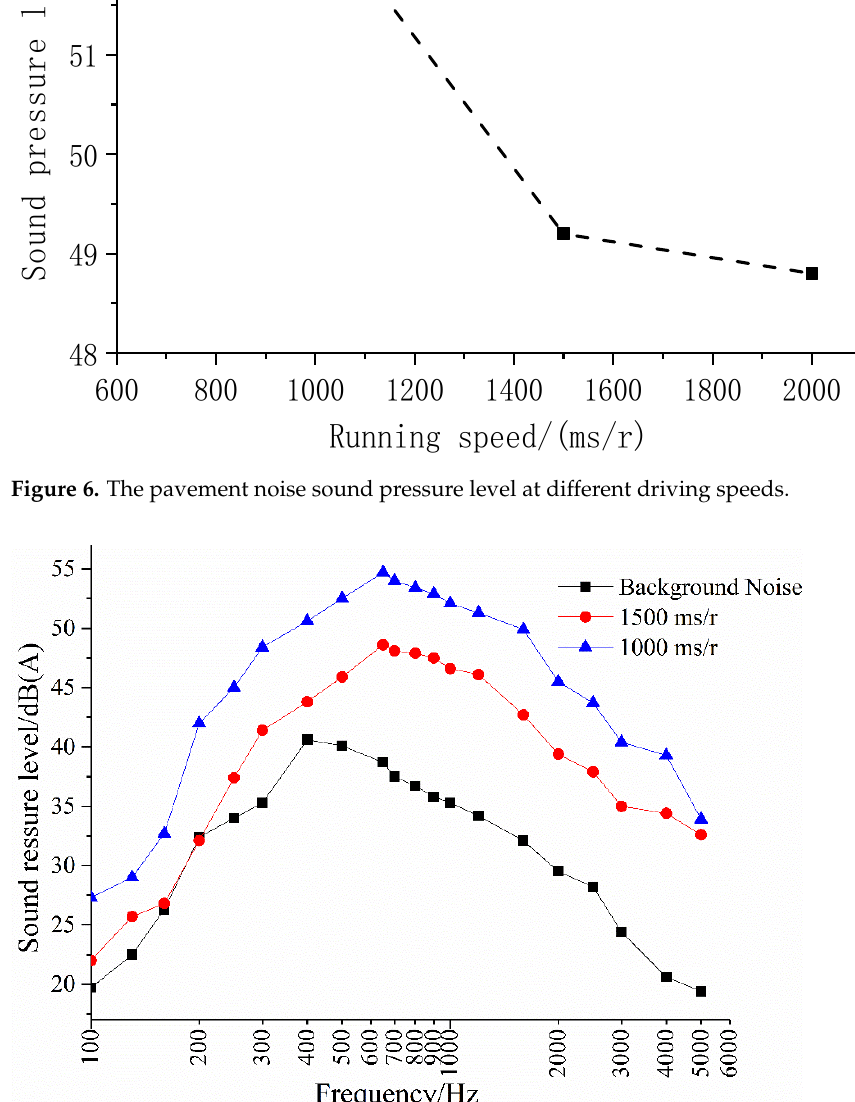
Table 8. A comparison of OGFC pavement noise in dry and wet